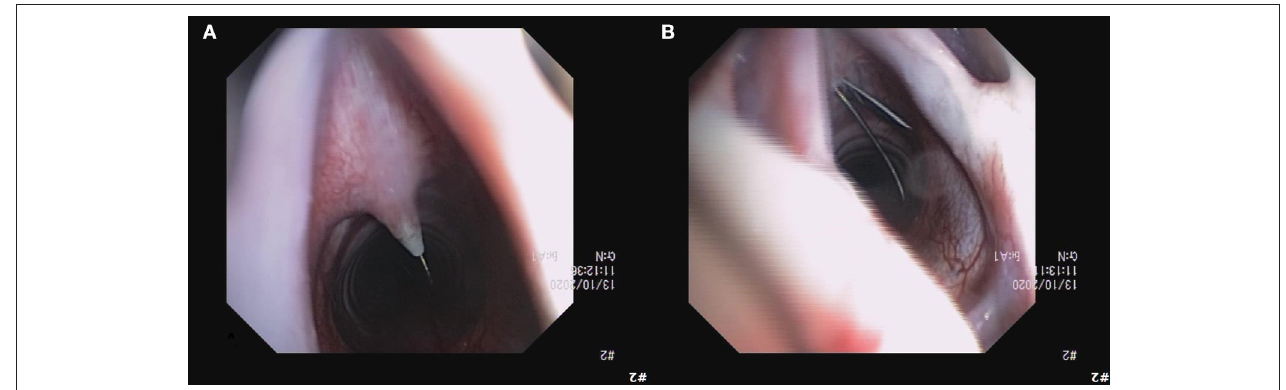
FIGURE 9 | Image of unsuccessful dilation over the guidewire (A) , requiring a stab incision in to the CTM with the guidewire in situ (B) . Subsequent procedures with the Melker kit implementing an incision in to the CTM before placing the guidewire were successful without